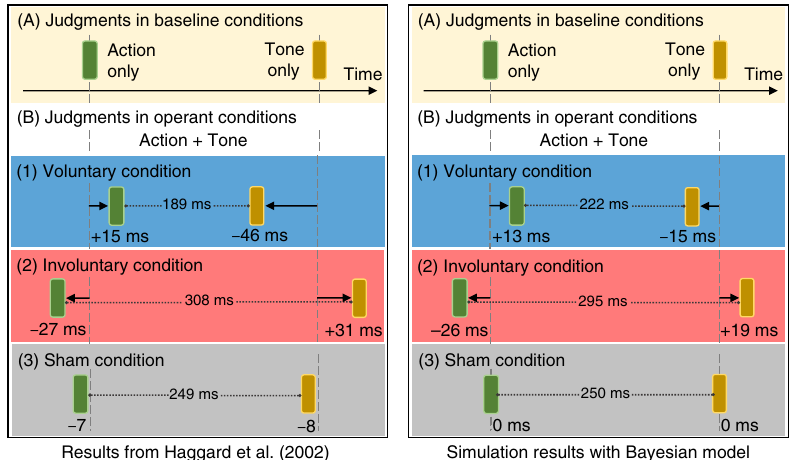
Fig. 1 Qualitative replication of the empirical results reported by Haggard et al. 3 . Each subject ’ s mean judgment error in the single-event baseline condition was subtracted from the mean judgment error for the corresponding event in the operant condition. This resulted in the values underneath the blocks that indicate the magnitude and direction to which the temporal perceptions shifted. A positive perceptual shift informs delayed awareness and a negative shift informs anticipated awareness. The action and outcome timings are perceived to shift towards each other in the voluntary condition. In contrast, they are perceived to repulse in the involuntary condition. There is no discernible perceptual shift in the sham